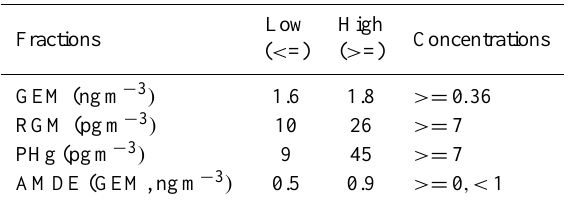
Table 1. Thresholds for high and low concentrations used in the correlation